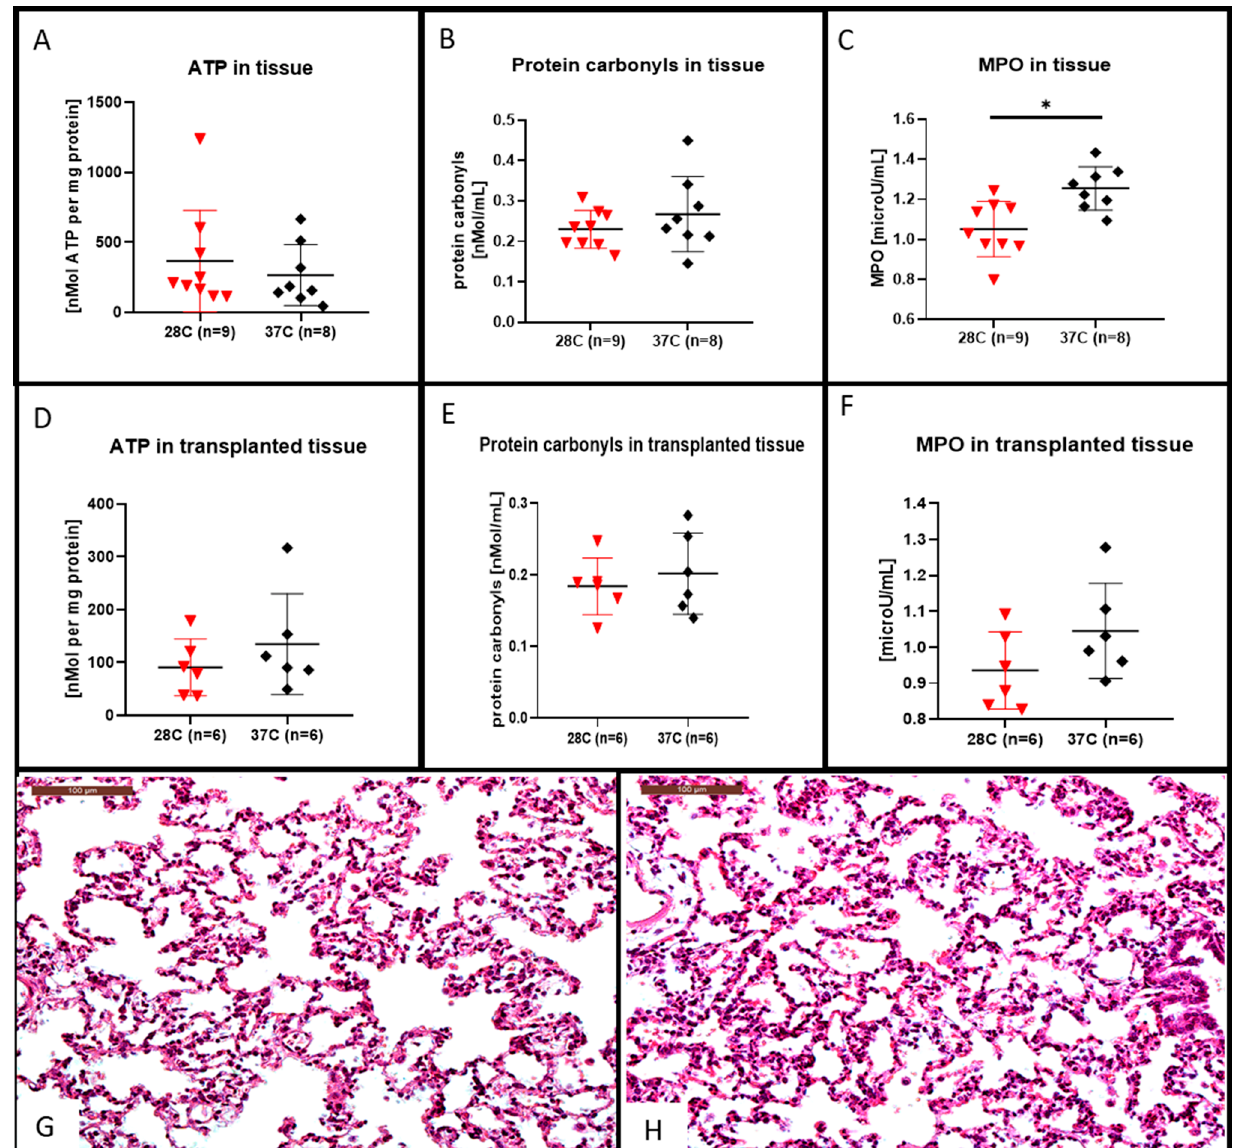
Figure 4. Hematoxylin and eosin stained lung sections, ATP, protein carbonyl contents and myeloperoxidase (MPO) measurement in lung tissues. After the 4 h EVLP at 28 ◦ C, the ATP content was increased ( A ), the protein carbonyl content was decreased, ( B ) although those differences were not significant when compared to the 37 ◦ C EVLP. The MPO content recovered after 4 h of EVLP at 28 ◦ C was significantly lower than the control at 37 ◦ C, (( C ) * p < 0.05). In the transplanted lung tissue of the 28 ◦ C group, the ATP content ( D ) and the protein carbonyl content ( E ) were both decreased, although those differences were not significant when compared to the 37 ◦ C group. In ( F ), the MPO content recovered 2 h after transplantation in the 28 ◦ C group was lower, although those differences were not statistically different from the control at 37 ◦ C. Representative hematoxylin and eosin stained sections for assessment of lung injuries in the subnormothermic group ( G ) and the normothermic group ( H ). Sections are shown at X200 magnification at the end of the 2 h transplantation period. The scale bar indicates 100 µ m